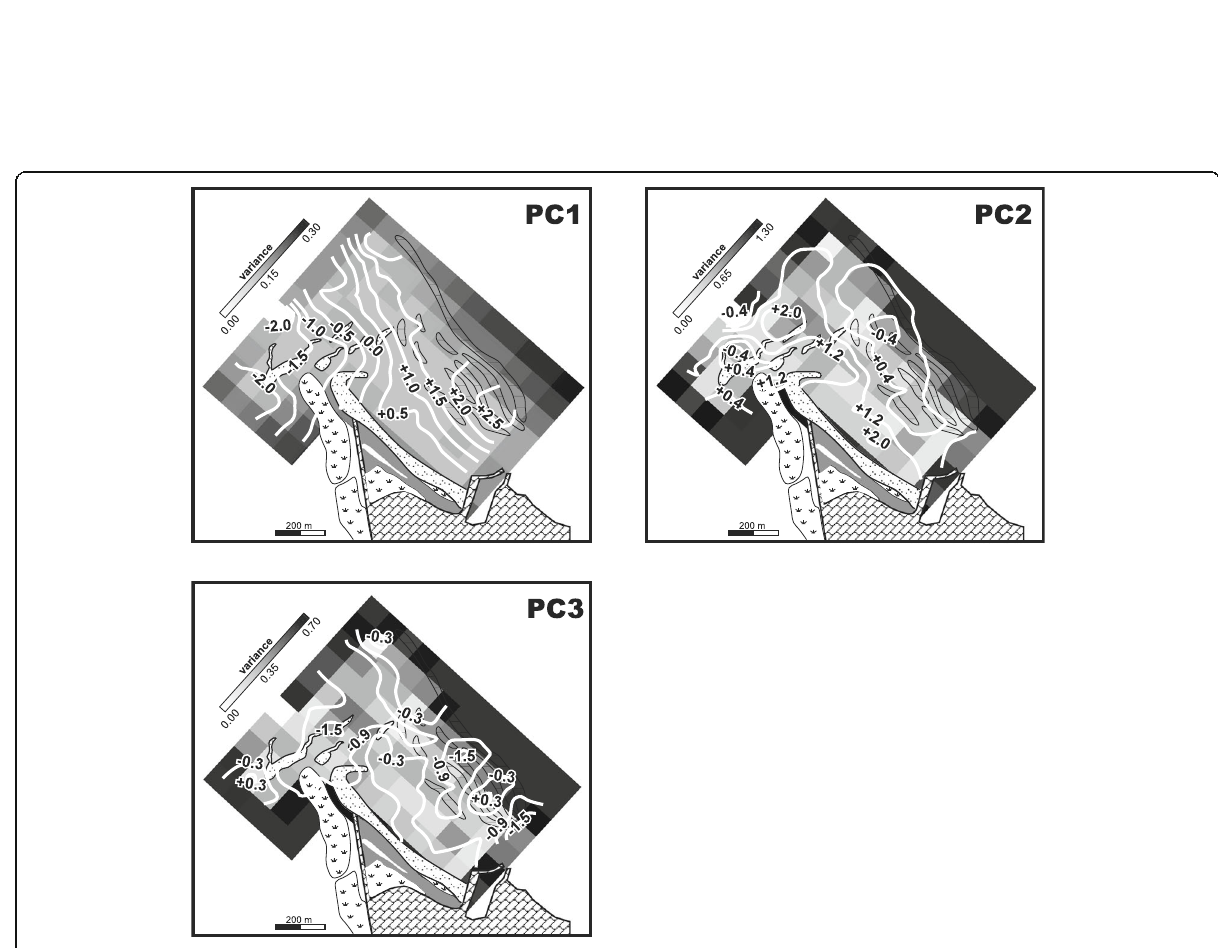
Fig. 9 Contour maps of the principal components interpolated by kriging over raster maps of estimation